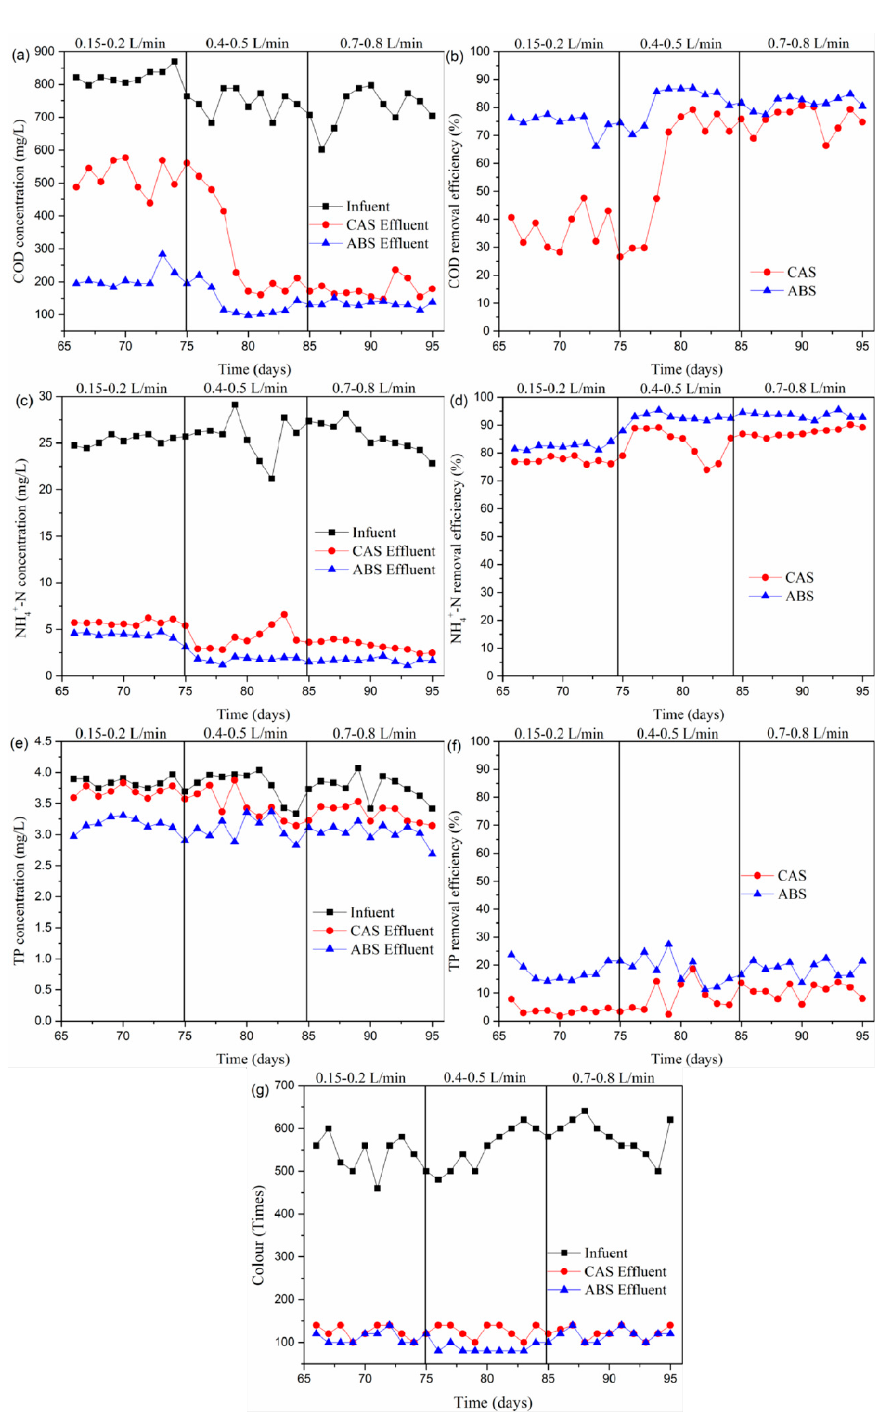
Figure 9. Removal performance of COD ( a , b ), NH 4+ -N( c , d ), TP ( e , f ) and colour ( g ) in the CAS system and ABS system under different aeration: 0.15–0.2 L/min, 0.4–0.5 L/min and 0.7–0.8 L/min, and the same HRT: 16 h.